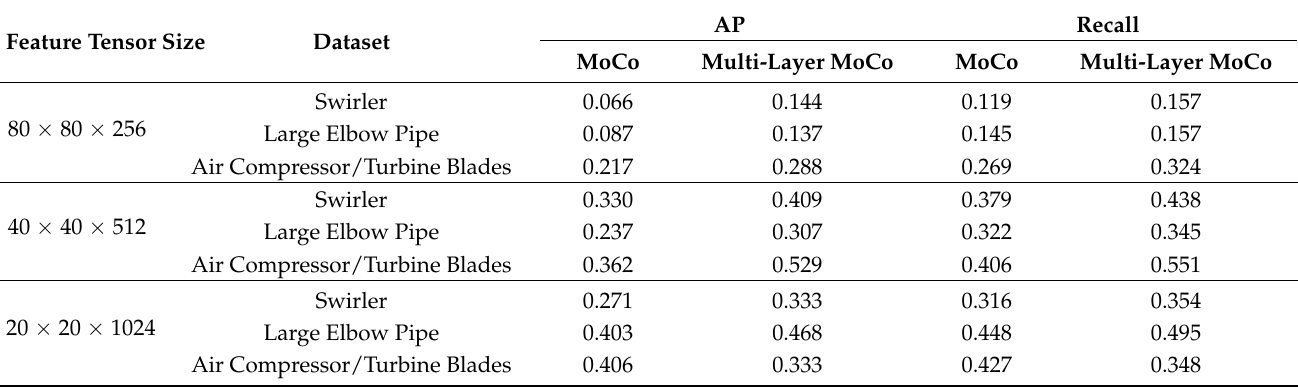
Table 5. Performance scores of different feature layers for damage detection in the MoCo method and the multi-layer MoCo